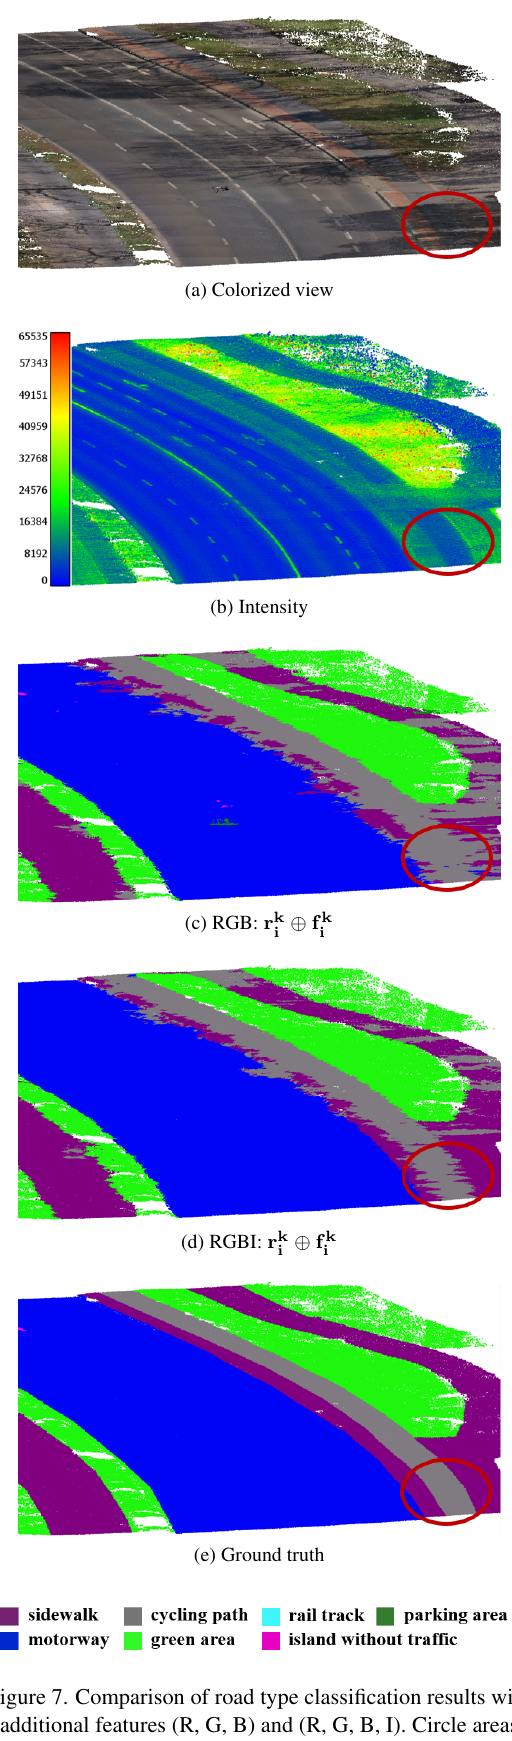
Figure 7. Comparison of road type classification results with additional features (R, G, B) and (R, G, B, I). Circle areas indicate the impact of the intensity